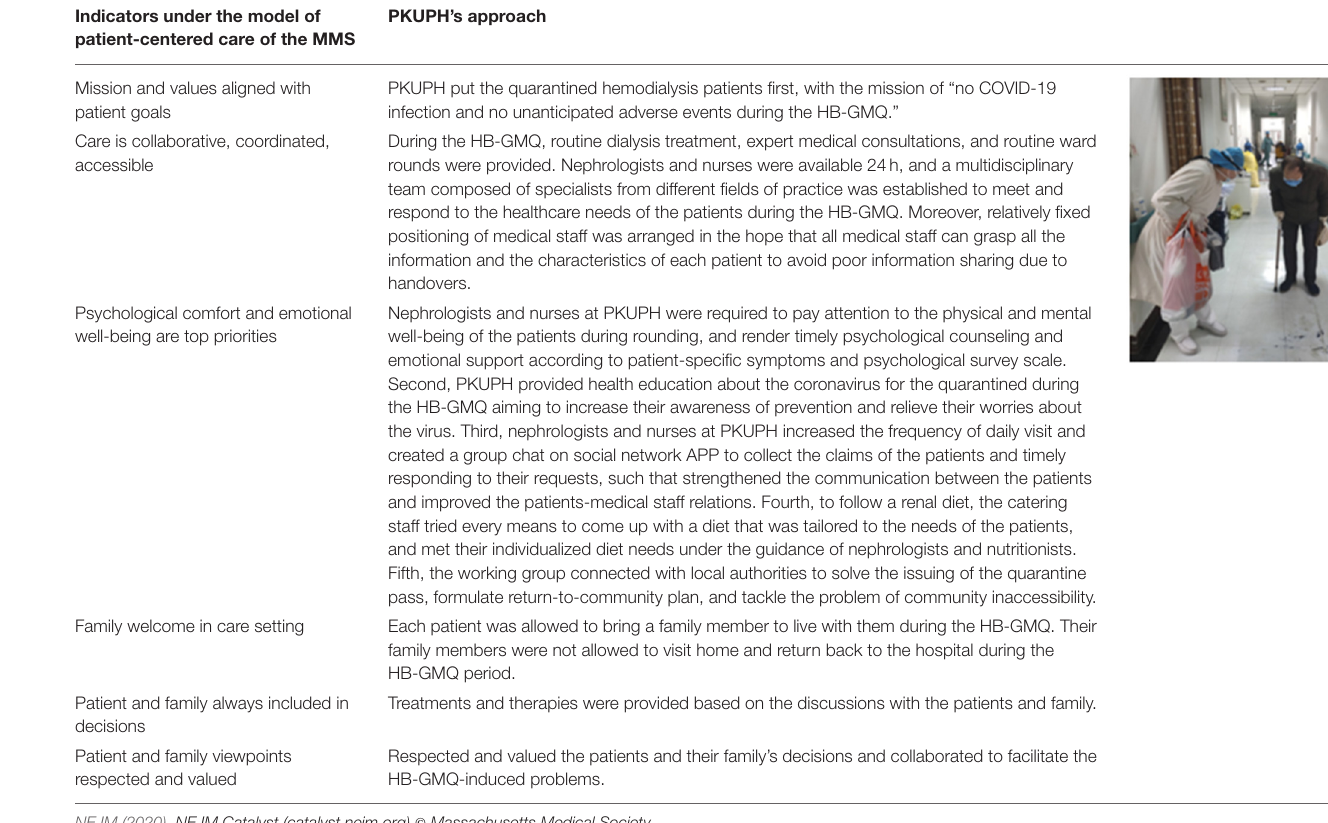
PKUPH’s approach